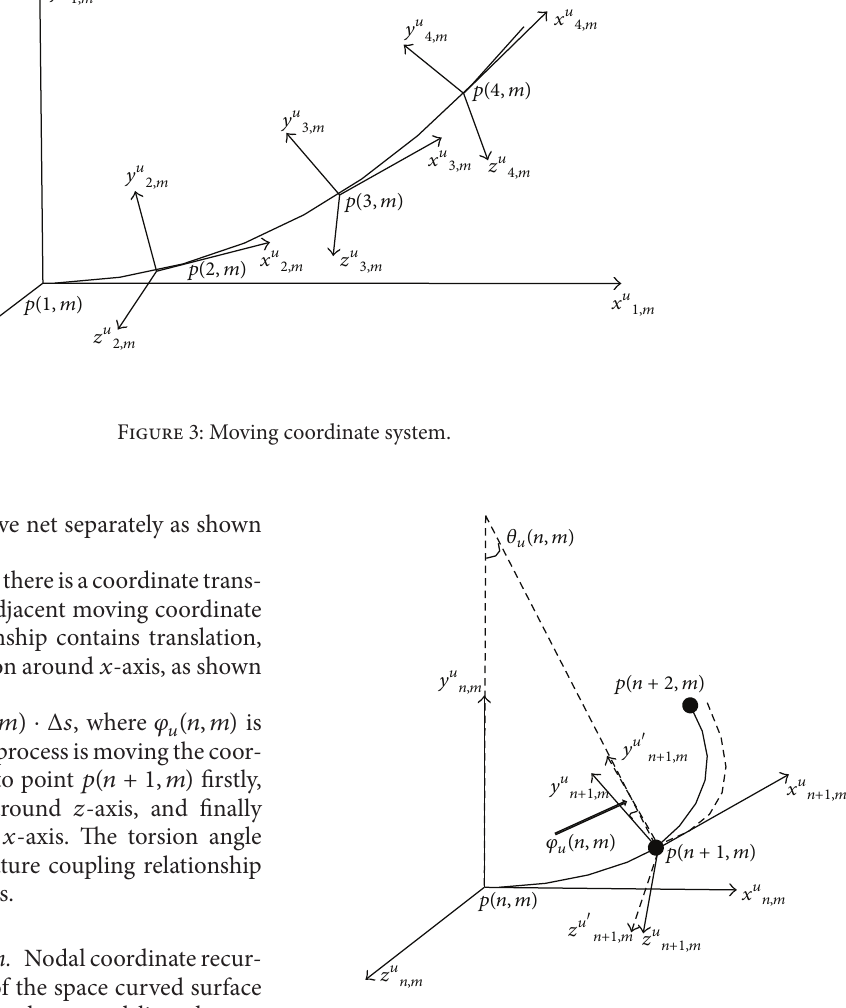
Figure 4: Moving coordinate system